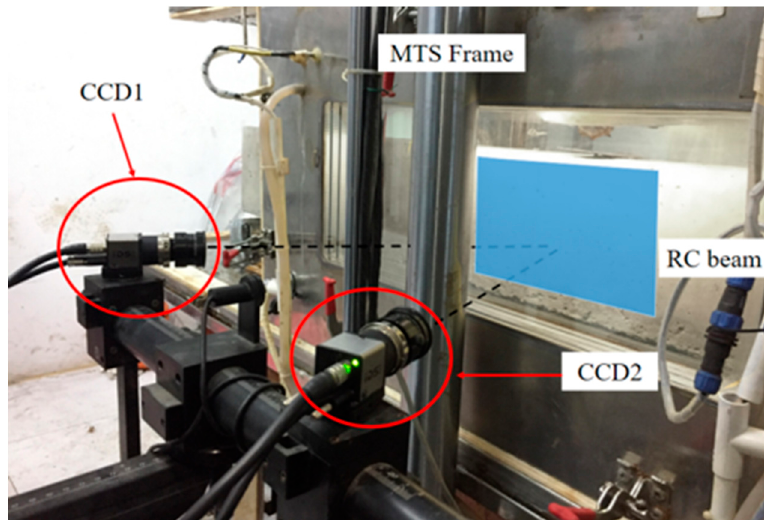
Figure 8. 3D-DIC system.